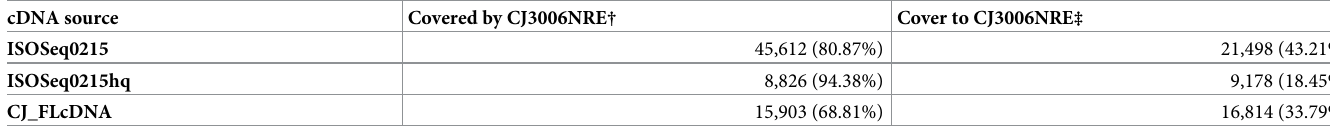
Table 2. The cDNA source and coverage by and to